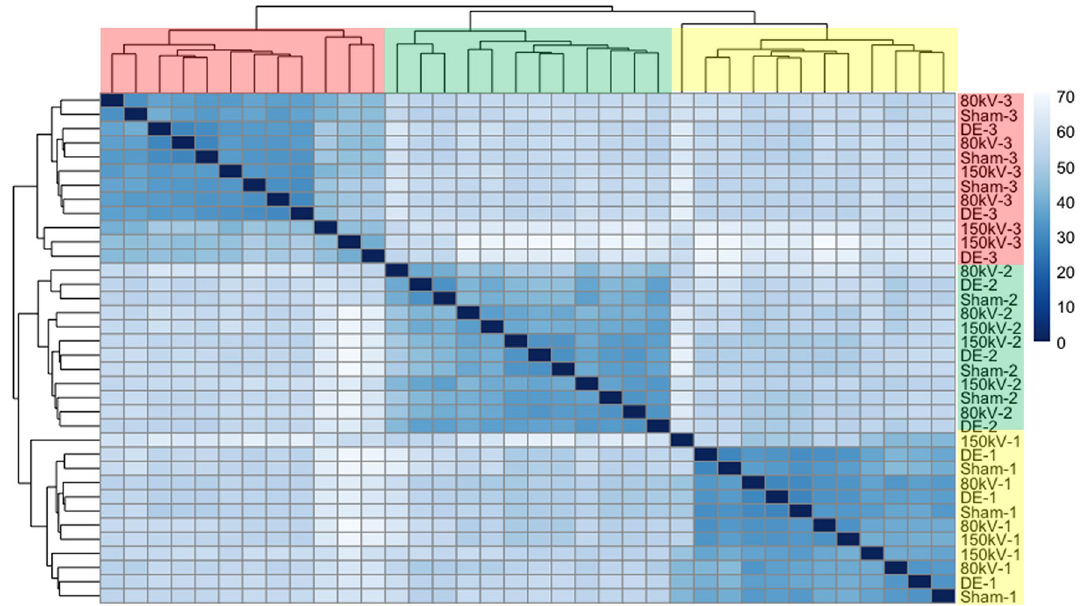
Figure 1. Unsupervised hierarchical clustering based on sample-to-sample distances of all 36 RNA sequencing experiments. Naming of samples indicates treatment (Sham, 80 kV, 150 kV and DE) and proband (1, 2, 3). Probands have additionally been highlighted in yellow (proband 1), green (proband 2) and red (proband 3) to the right and at the top of the heatmap. The order of samples in combination with the dendrogram at the top or to the left of the heatmap denote the clusters of samples arising as a result of the hierarchical clustering process. Given the dominance of inter-individual differences of gene expression profiles over CT-induced effects, all samples derived from the respective probands group together in distinct clusters, independent of whether they have been irradiated or not. Within the heatmap sample-to-sample distance based on log2-transformed normalized read count data is displayed by a blue color gradient with dark blue indicating a high degree of